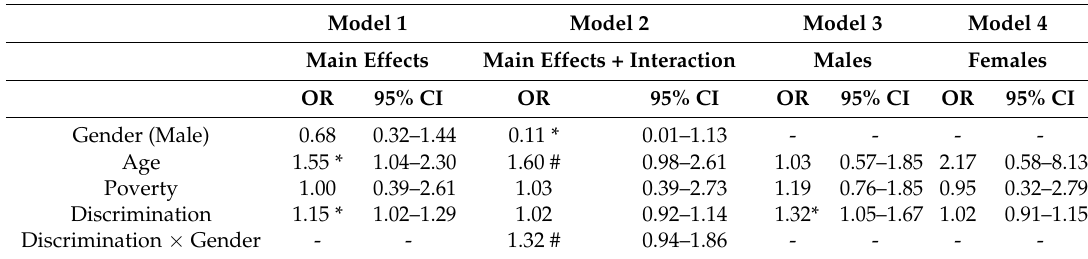
Table 3. Logistic regressions on the association between perceived discrimination and substance use among Caribbean Black